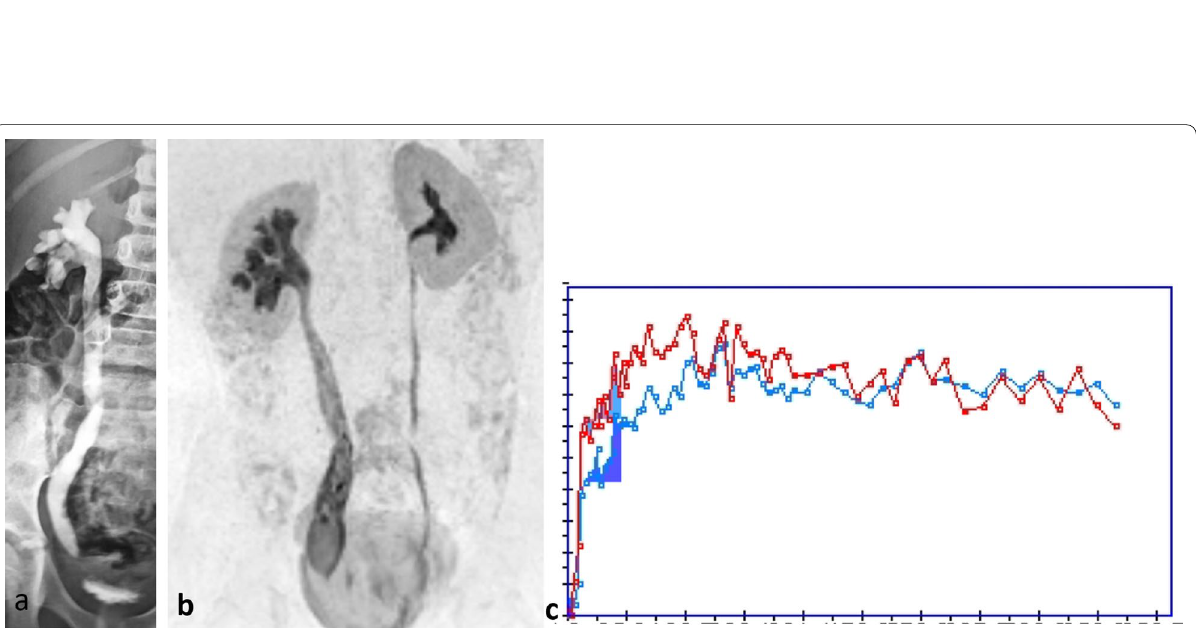
Fig. 8 4-year-old girl with right sided urinary tract dilatation (P3) (hydroureter and hydronephrosis) due to primary megaureter. MCUG was unremarkable. She underwent IVP elsewhere ( a ) and confirms presence of hydroureter and hydronephrosis in addition to hold up of the contrast at the distal ureteric end. b Dynamic MRU at our institution confirms the same findings with symmetric nephrograms and signal intensity versus time curves ( c ) with symmetric calyceal transit time (99 s) indicating compensated hydronephrotic